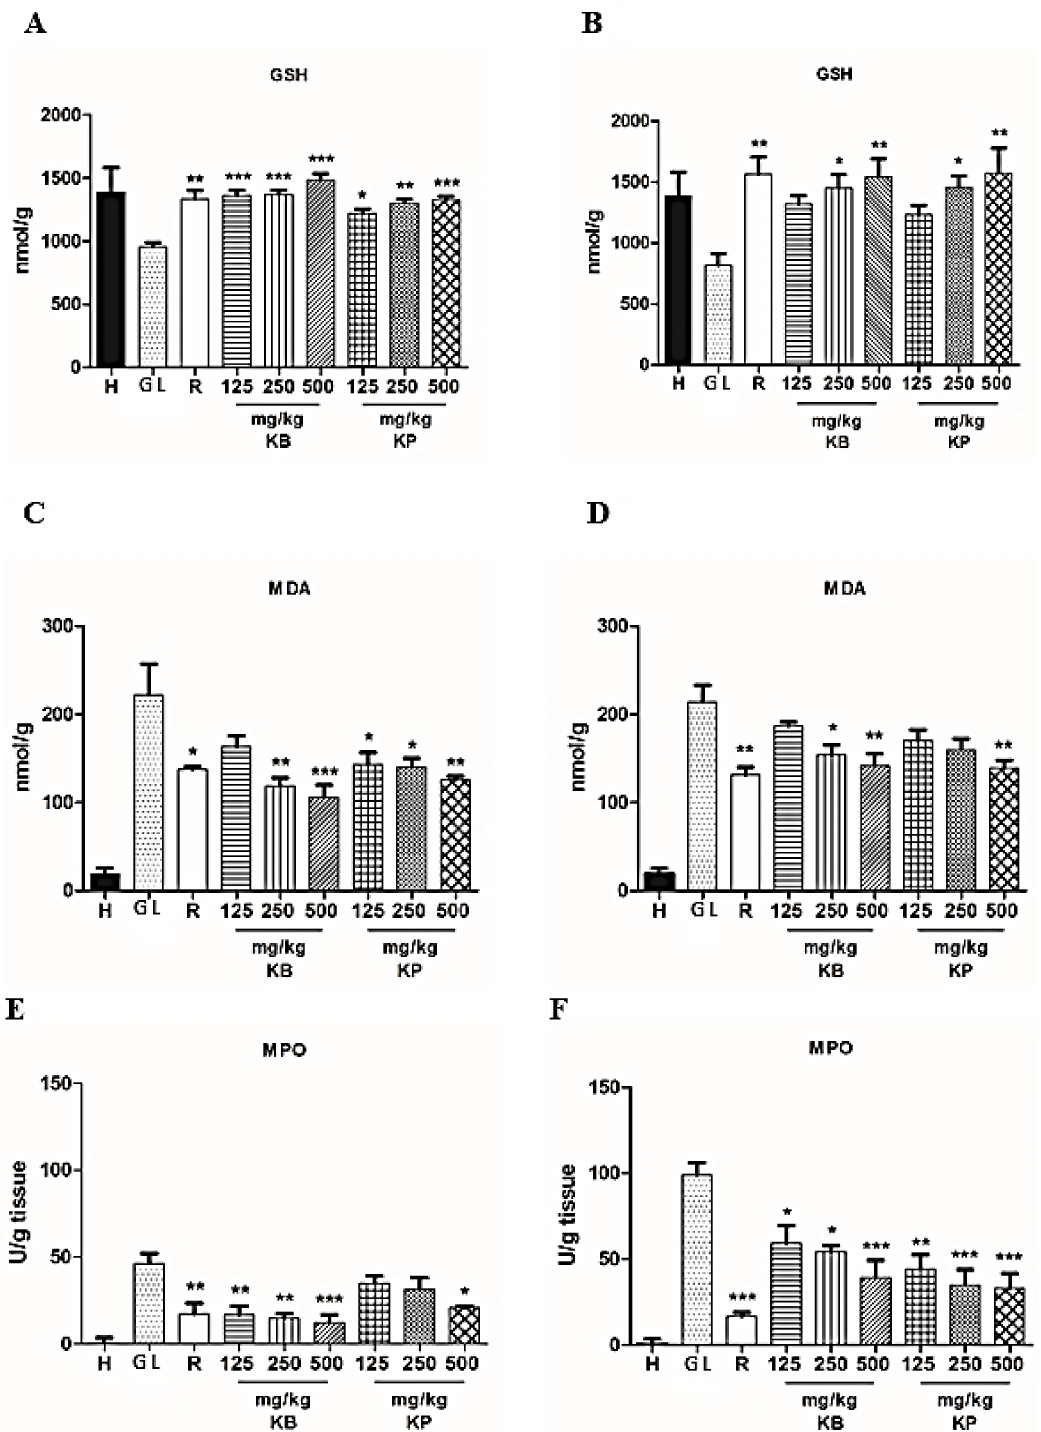
Figure 4. Effect of pre-treatment with K. brasiliensis and K. pinnata leaf juice (125, 250 and 500 mg/kg) on GSH (( A ) ethanol-induced and ( B ) indomethacin-induced), MDA (( C ) ethanol-induced and ( D ) indomethacin-induced) and MPO (( E ) ethanol-induced and ( F ) indomethacin-induced) in the gastric mucosa homogenate of lesions in rats. Results expressed as mean ± standard mean error, ( n = 7). ANOVA and Tukey post-test were used to calculate the statistical significance, * p < 0.05, ** p < 0.01 and *** p < 0.001 vs. gastric lesion control. Healthy, H; Gastric lesion control, GL; Ranitidine (50 mg/kg),